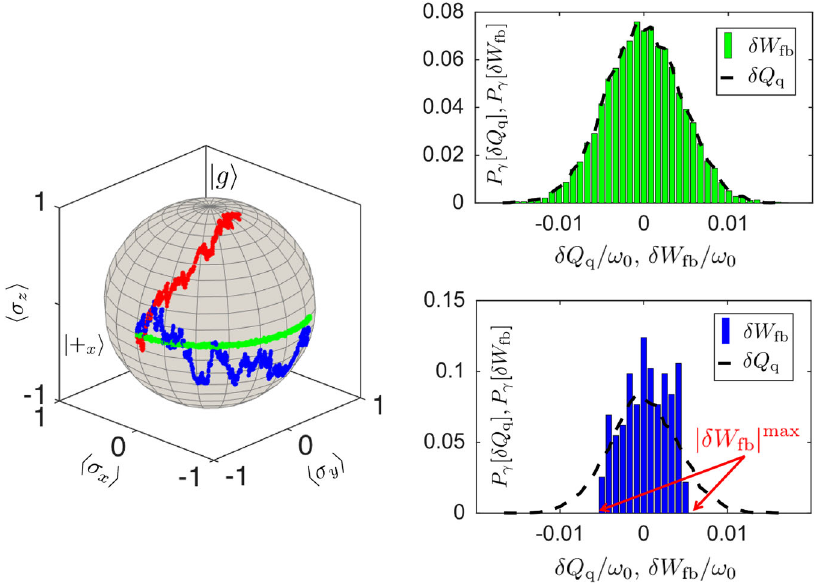
(cid:1) (cid:3) (cid:1) Fig. 4 Analysis of a feedback protocol stabilizing the state ψ ¼ exp ð(cid:2) i ω 0 σ z t = 2 Þ þ x j i . Left : Trajectory in the Bloch sphere in the case of target ð t Þ perfect feedback ( green ), imperfect feedback ( blue ) and without feedback ( red ). Right : Normalized distributions of quantum heat increments P γ [ δ Q q ] ( dashed black ) and feedback work P γ [ δ W fb ] ( bars ) performed by the feedback source F . The work distribution P γ [ δ W fb ] is de fi ned like in Eq. 28. Top right : The two distributions match, such that the state is perfectly stabilized. Bottom right : The distribution of P γ [ δ W fb ] is bounded and the feedback is not perfect. Parameters: (cid:1) h ¼ 1 , evolution time T = 1.5/ ω 0 , pure dephasing rate Γ * = 0.1 ω 0 , feedback work cutoff: j δ W fb j max ¼ 0 : 05 ω